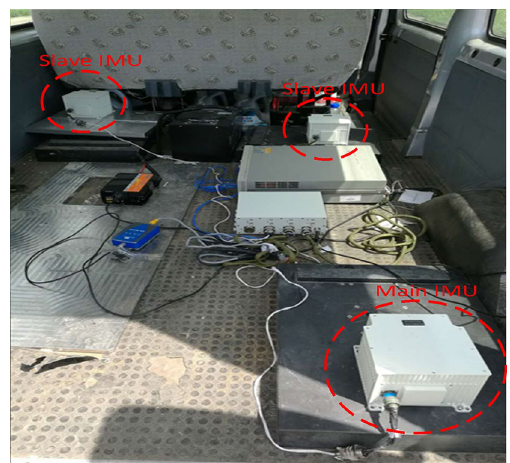
Figure 5. The land vehicle experiment.